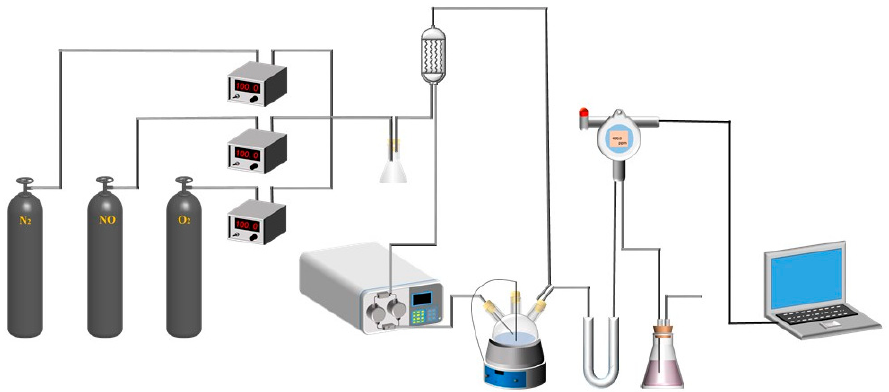
Figure 2. Schematic diagram of experimental setup.